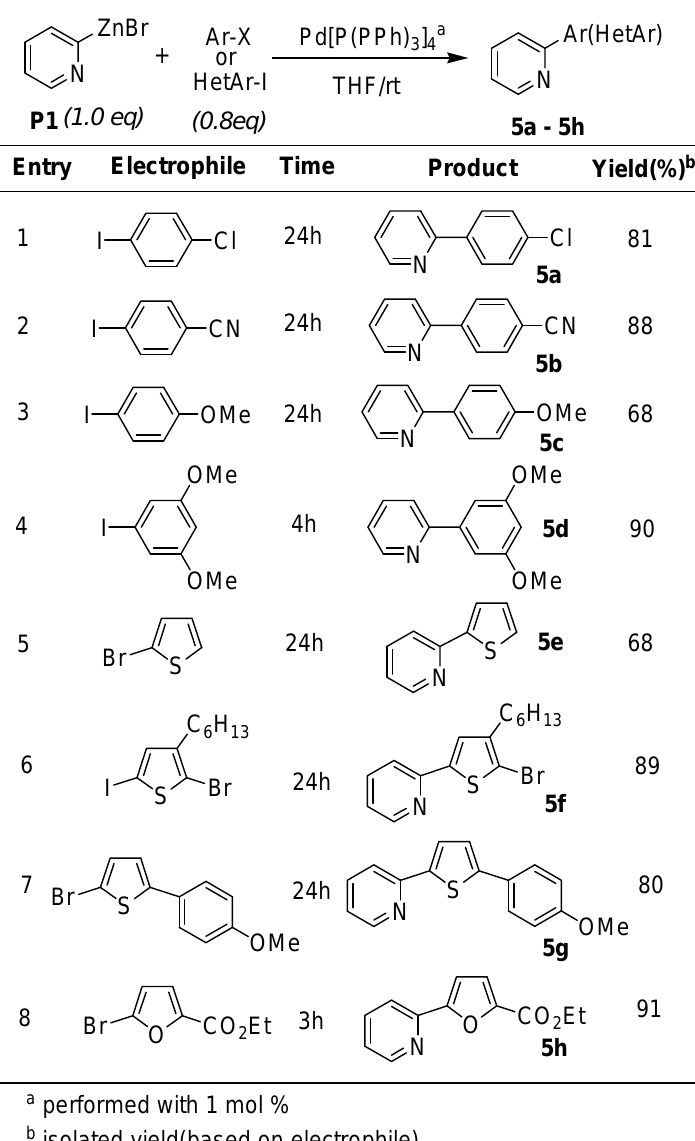
Table 5. Pd-catalyzed coupling of P1 with